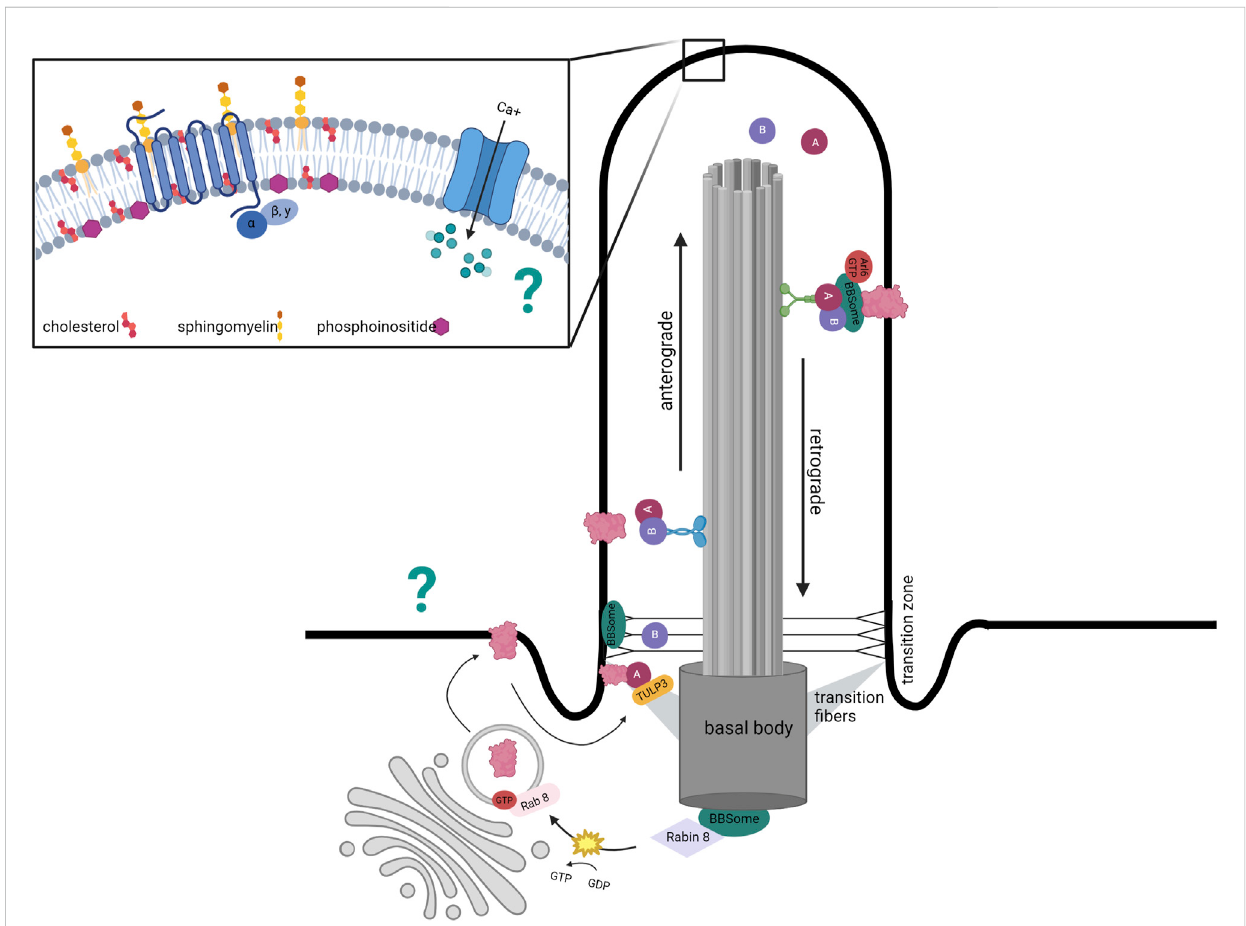
FIGURE 1 Distinct mechanism of ciliary protein transport. Structure of primary cilium to highlight distinct ciliary membrane composition in inset. Ciliary traf fi cking of receptors such as GPCRs involves vesicle budding from the Golgi that docks at the base of the cilium with intra fl agellar (IFT)- mediated transportation via anterograde kinesin motors. IFT-A-mediated entry requires TUB like protein 3 (TULP3), a member of the Tubby family of proteins that interacts with the IFT-A core as an effector. The BBSome localizes to the basal body and transitionzone and represents a docking point for proteins destined to enter the cilium. The BBSome has also been implicated in the exit of ciliary GPCRs out of the cilium as disruption of its functions leads to accumulationofGPCRswithinthecilium.InadditiontotheBBSome,removalofproteinsismediatedbyretrogradetransportwithIFTcomplexescoupled to dynein motors. The question mark represents the uncertainty regarding how GPCR- associated cAMP and calcium oscillations are transmitted from the cilium to the rest of the